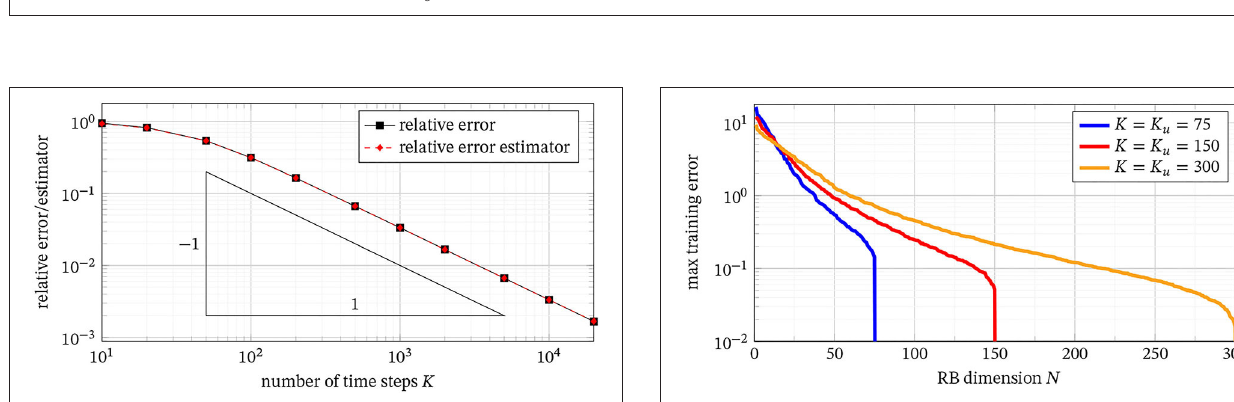
(right) right-hand side. S